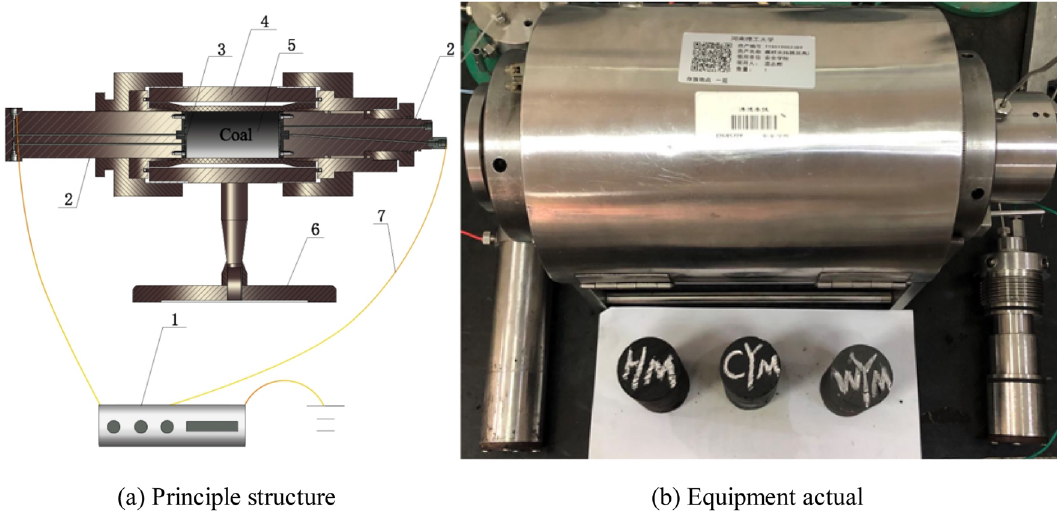
Figure 1. Structure of experimental apparatus for coal sample testing in an applied DC field. 1—high voltage power supply; 2—rod electrodes; 3—red copper electrode plates; 4—holder; 5—coal sample; 6—insulating support; 7—power